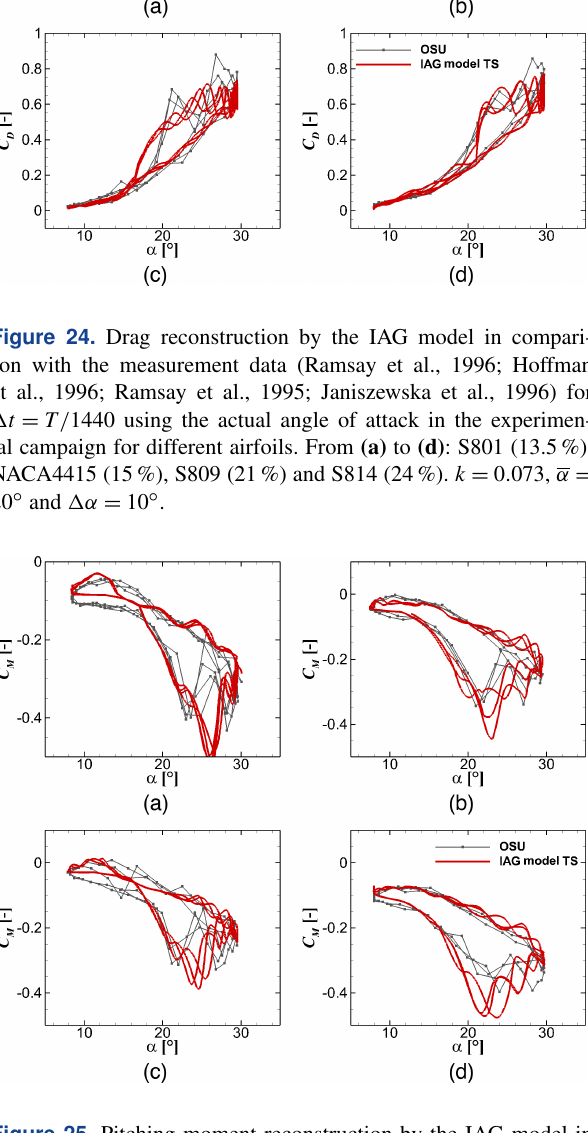
Figure 25. Pitching moment reconstruction by the IAG model in comparison with the measurement data (Ramsay et al., 1996; Hoff- man et al., 1996; Ramsay et al., 1995; Janiszewska et al., 1996) for (cid:49)t = T/ 1440 using the actual angle of attack in the experimen- tal campaign for different airfoils. From (a) to (d) : S801 (13.5%), NACA4415 (15%), S809 (21%) and S814 (24%). k = 0 . 073, α = 20 ◦ and (cid:49)α = 10 ◦